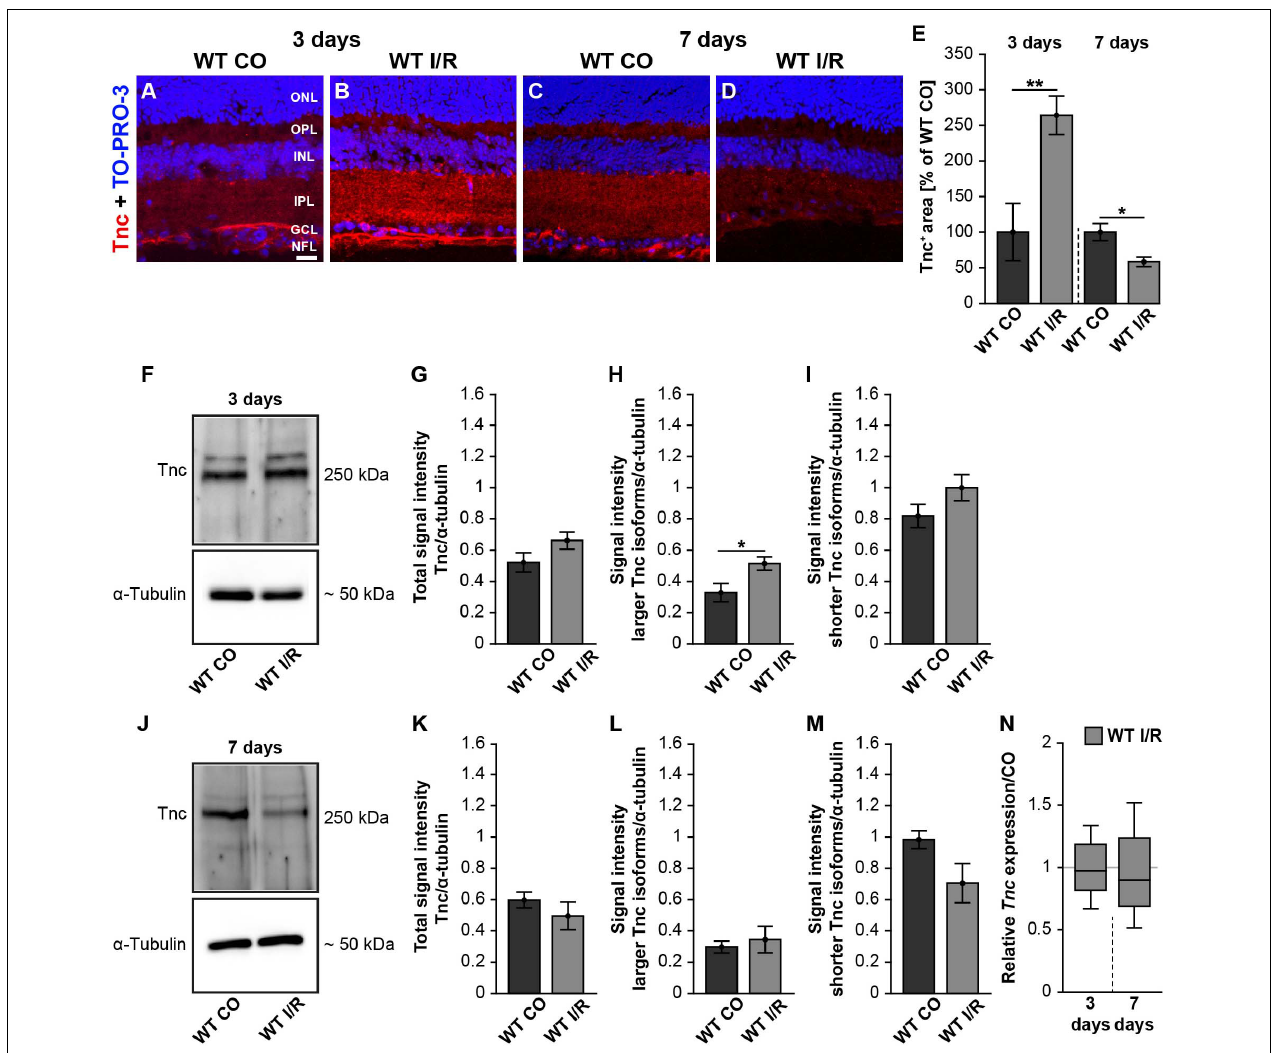
FIGURE 1 | Early induction of Tnc in the ischemic WT retina. (A–D) Images of Tnc stained retinal cross-sections from control and ischemic WT groups at 3 and 7 days. Immunohistochemistry revealed a Tnc signal in the IPL and OPL as well as in the NFL (red). Cell nuclei were counterstained with TO-PRO-3 (blue). (E) Tnc + staining area was significantly increased at 3 days, indicating an early induction of Tnc after ischemic injury. However, a significantly reduced Tnc staining could be demonstrated at 7 days. The WT CO group was set to 100%. (F–I) Consistently, relative protein quantification showed a significant upregulation of larger Tnc isoforms at 3 days after I/R. (J–M) Comparable Tnc protein levels were observed after 7 days. (N) No differences of the Tnc mRNA expression were noted at both points in time after ischemia. Data were analyzed via Student t -test and presented as mean ± standard error mean (SEM) in panels (E,G–I,K–M) . For RT-qPCR, groups were compared using the pairwise fixed reallocation and randomization test in panel (N) . These data are shown as median ± quartile ± minimum/maximum. * p < 0.05; ** p < 0.01. n = 4–5/group. Scale bar = 20 µ m. ONL: outer nuclear layer, OPL: outer plexiform layer, INL: inner nuclear layer, IPL: inner plexiform layer, GCL: ganglion cell layer, NFL: nerve fiber